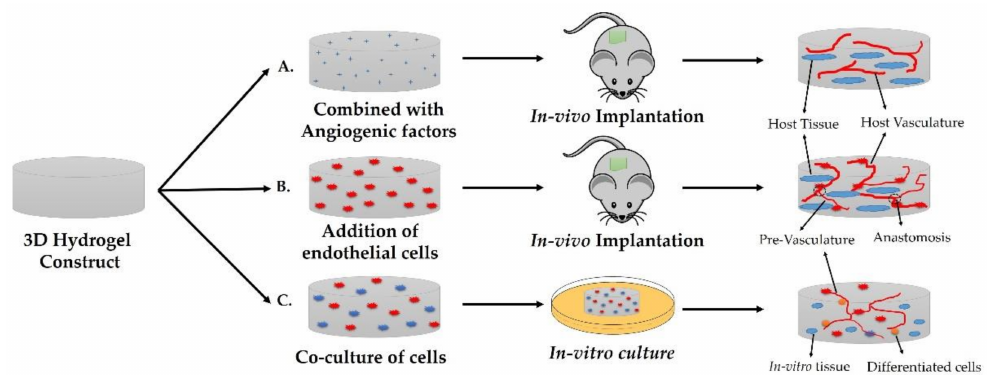
Figure 5. Vascularization strategies in 3D tissue construct. A. Hydrogel construct incorporated with angiogenic factors. Host vasculature developed in 3D construct upon in vivo implantation. B. Formation of pre-vascularization and anastomosis upon in vivo implantation of endothelial cell culture hydrogels. C. Co-culture study is more suitable in in vitro culture